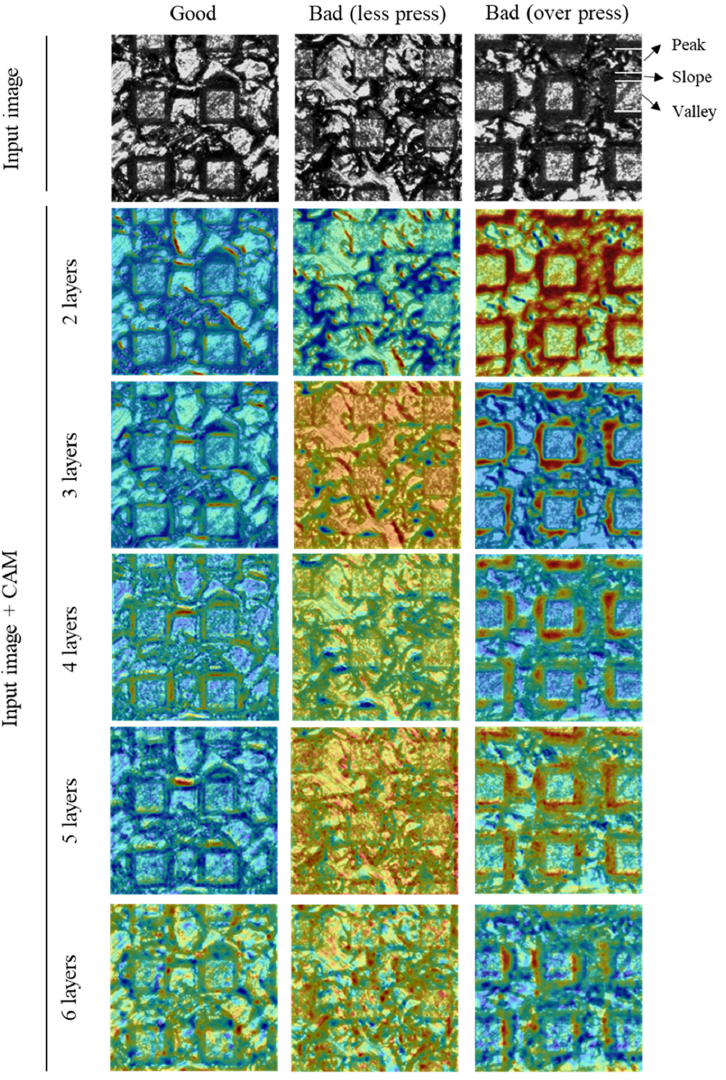
Figure 7. Changes in regions considered to be important in determining the CNN according to the number of layers. number of